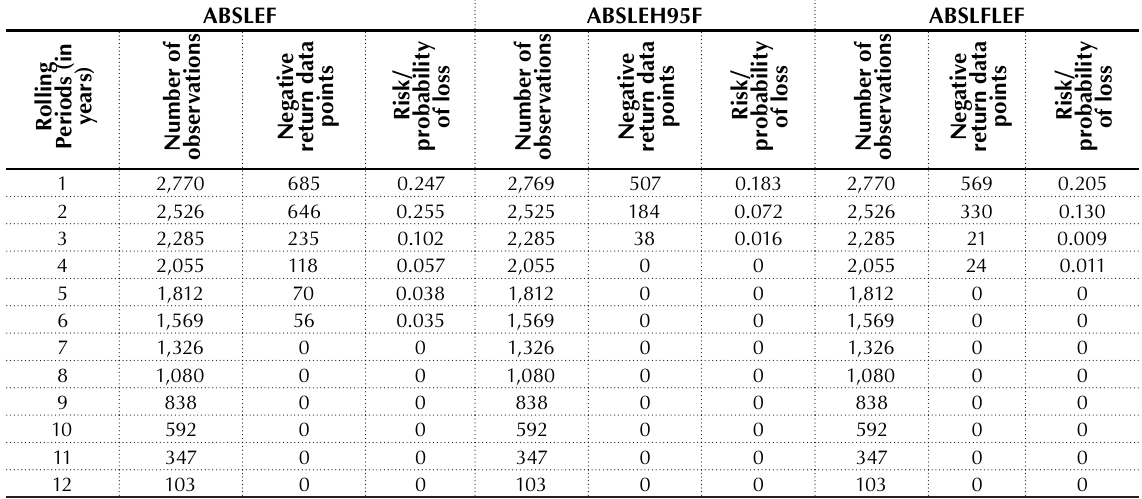
Table 14. Rolling period risk and return behavior of ABSLEF, ABSLEH95F and ABSLFLEF (2006–2018)